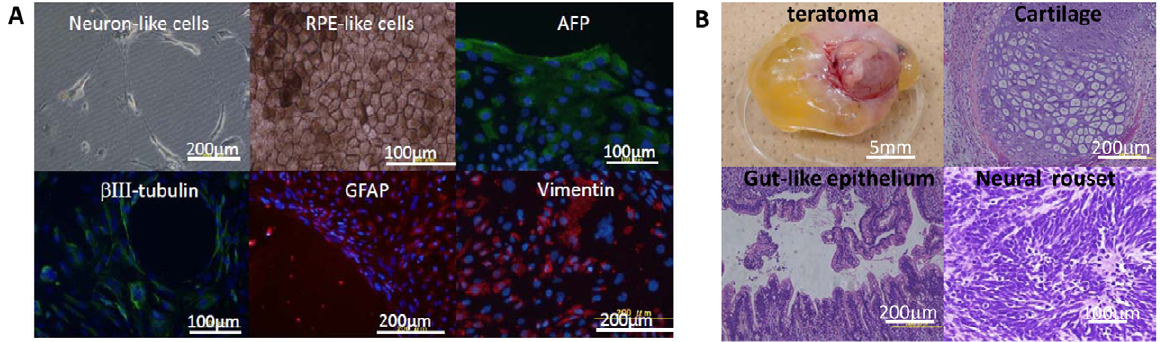
Figure 5. Invivo and invitro differentiation potential of established iPSC clones. (A) In vitro differentiation potential of established iPSC clones. Phase contrast images of neuron-like (top left) and retinal pigmented epithelium (RPE) differentiation (top middle) of established iPSCs clone PFX # 7. Cells were fixed and stained with antibodies against AFP, b III-tubulin, GFAP and vimentin to identify specific cell lineages. (B) Teratoma with cystic structure derived from iPSCs (PFX # 11) implanted in the testicular capsule of NOD-SCID mouse was stained with Hematoxylin and Eosin for histological observation.